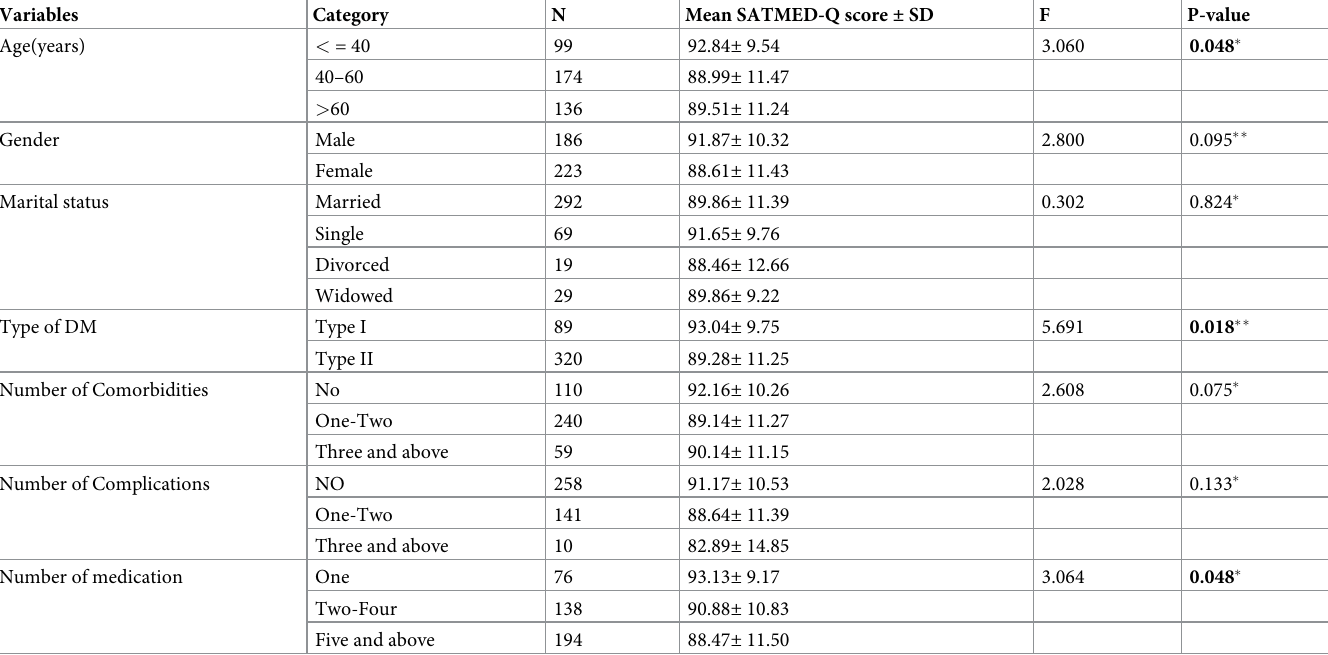
Table 5. Relationship between treatment satisfaction and different characteristics of patients with